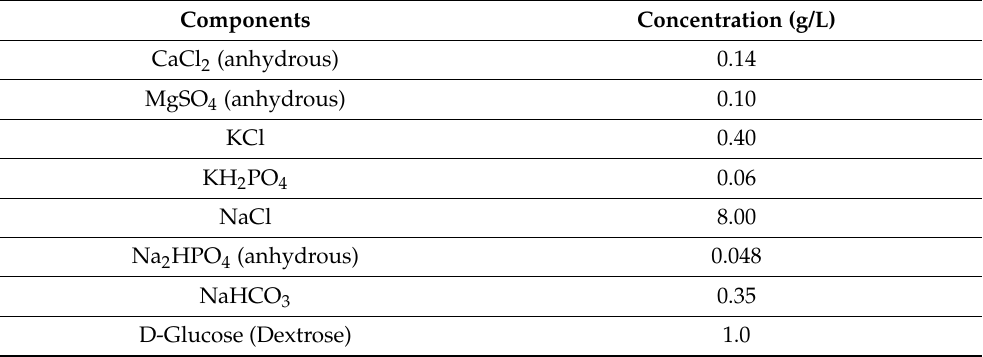
Table 2. Composition of Hank’s